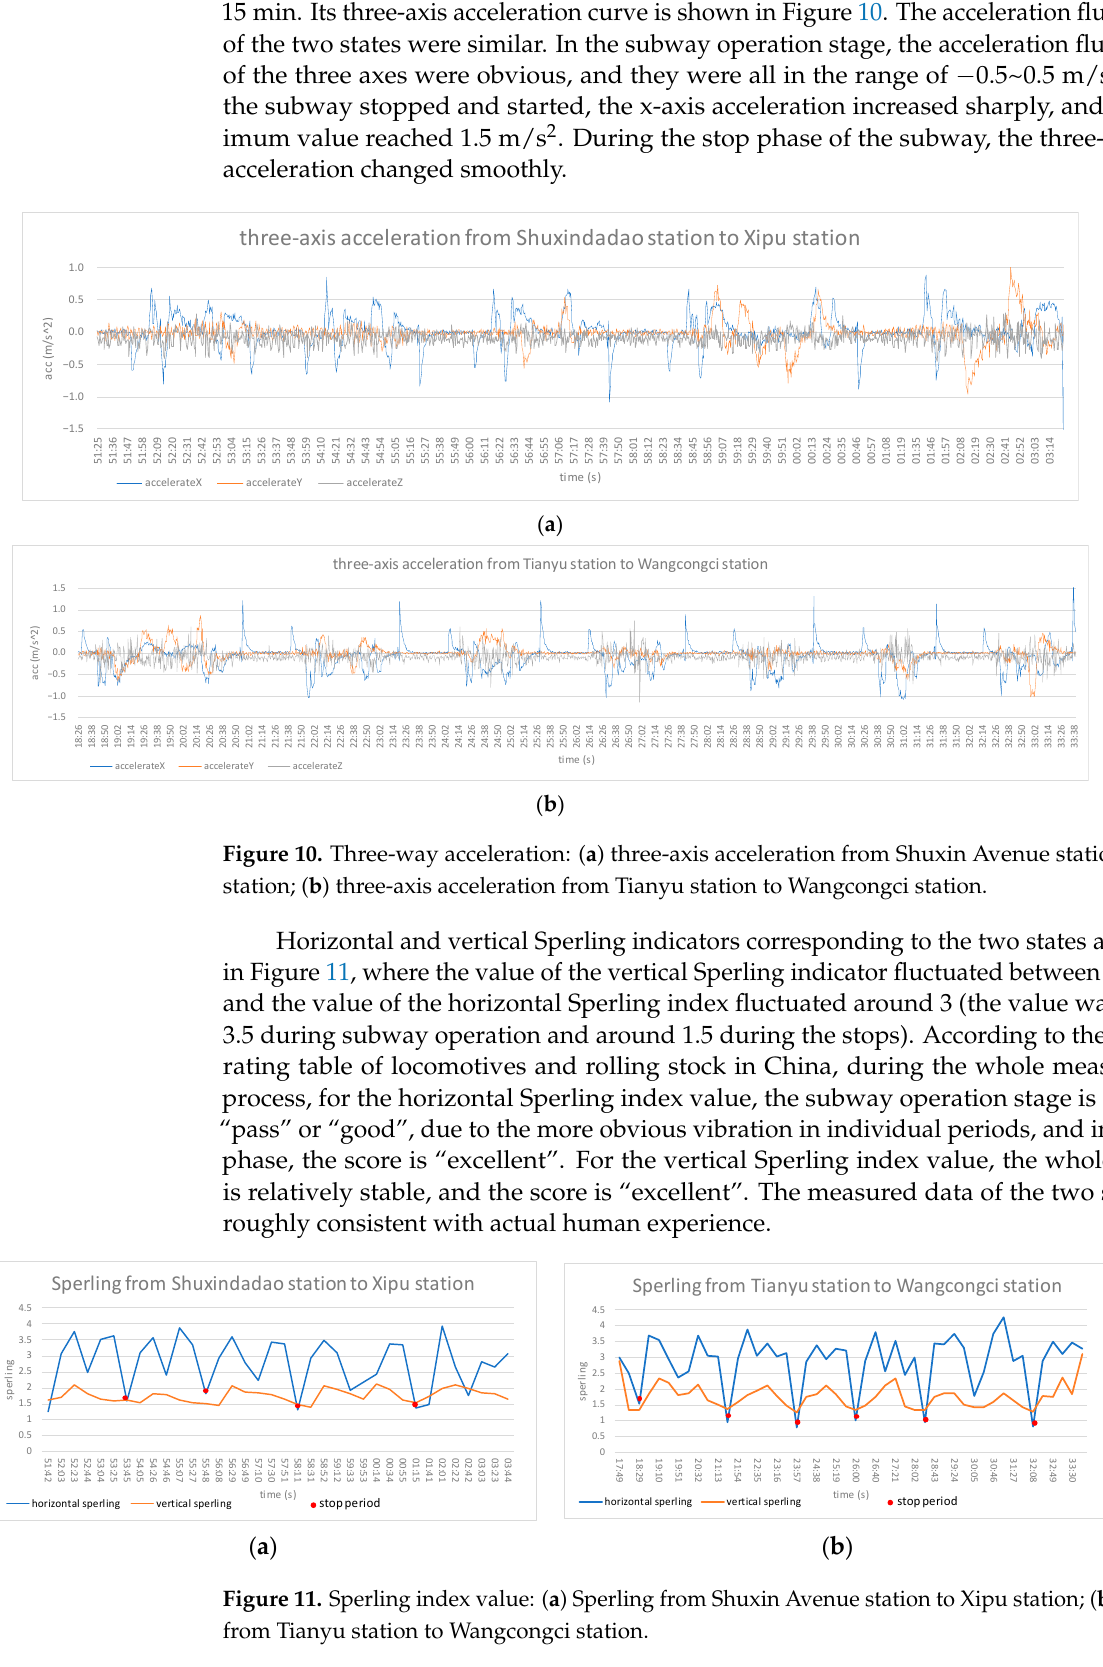
Figure 11. Sperling index value: ( a ) Sperling from Shuxin Avenue station to Xipu station; ( b ) Sperling from Tianyu station to Wangcongci station.